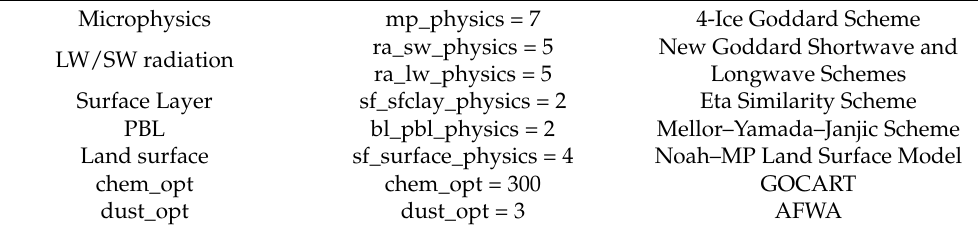
Table 1. Physical and chemical options and the namelist setting within the model.